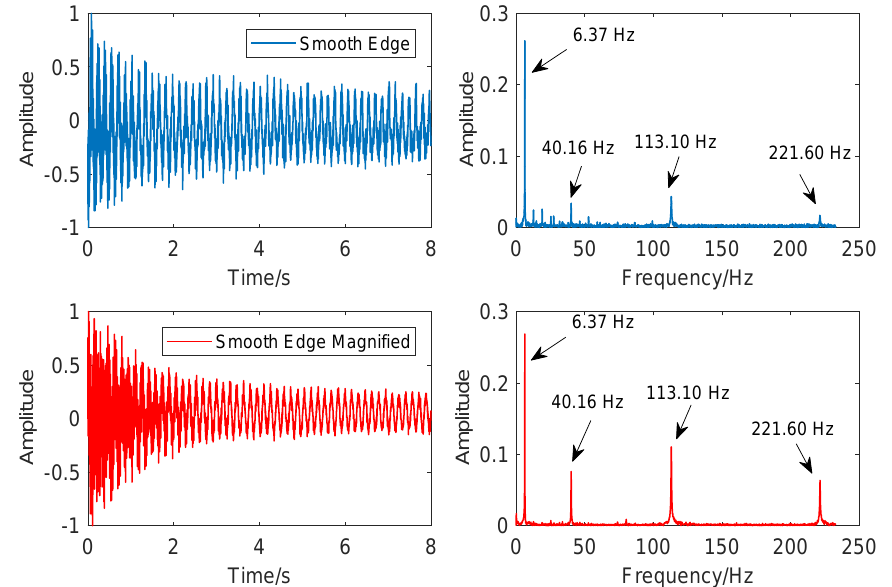
Figure 6. Vibration signals and their frequency spectrums extracted from the original video (blue line) and the magnified video (red line) along the smooth edge of the saw